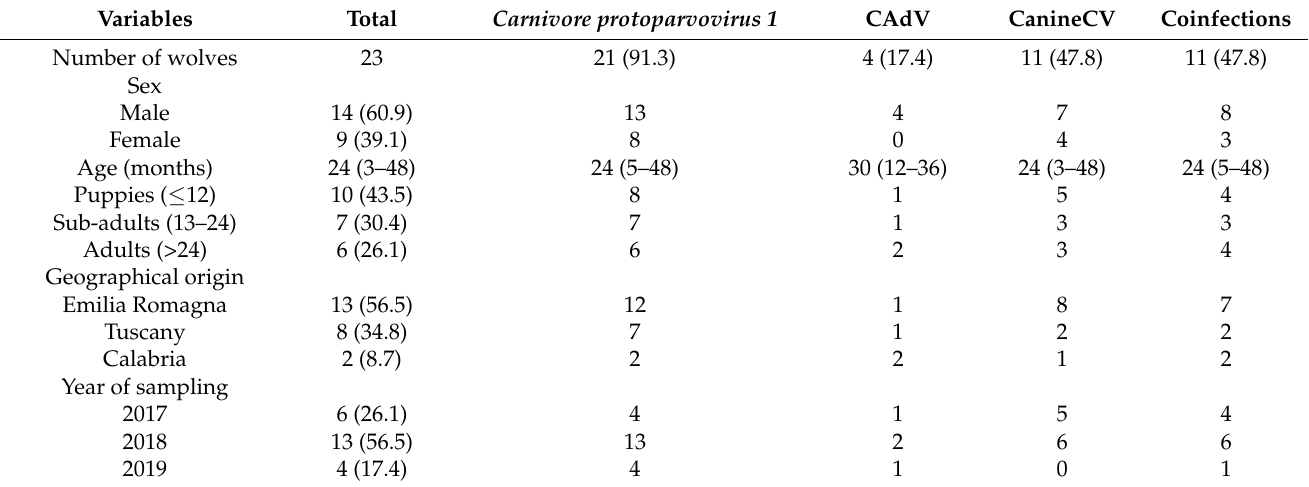
Data are expressed as the number of wolves (percentage in parentheses) or as the median (range in parentheses).